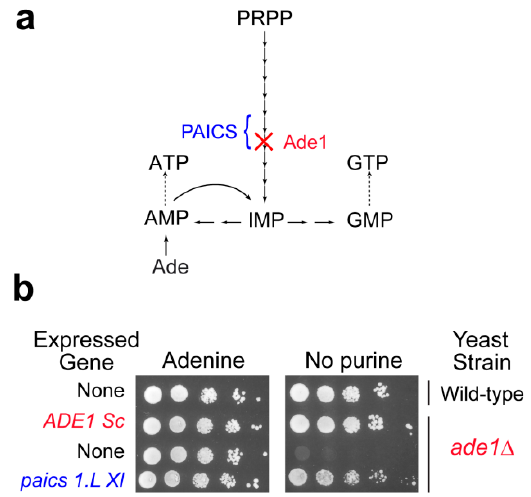
Figure 2. Functional complementation of the yeast phosphoribosyl aminoimidazole succinocarboxamide synthetase by the Xenopus laevis ortholog paics1.L . ( a ). Simplified scheme of the yeast purine pathway. ( b ). Yeast wild-type and knock-out mutant ( ade1 ∆ ) strains were either transformed with a plasmid allowing expression of the yeast ( ADE1 Sc) or the Xenopus laevis ( paics 1.L ) amino imidazole succinocarboxamide synthetase encoded gene, or with the empty vector (None). Serial dilutions (1/10) of transformants were dropped on SDCASAW medium to score the ability of the yeast and xenopus genes to complement the ade1 mutant auxotrophy observed in the absence of external purine source. A medium supplemented with adenine was used as a viability control of transformants and images were obtained after 34 h of growth at 37 ◦